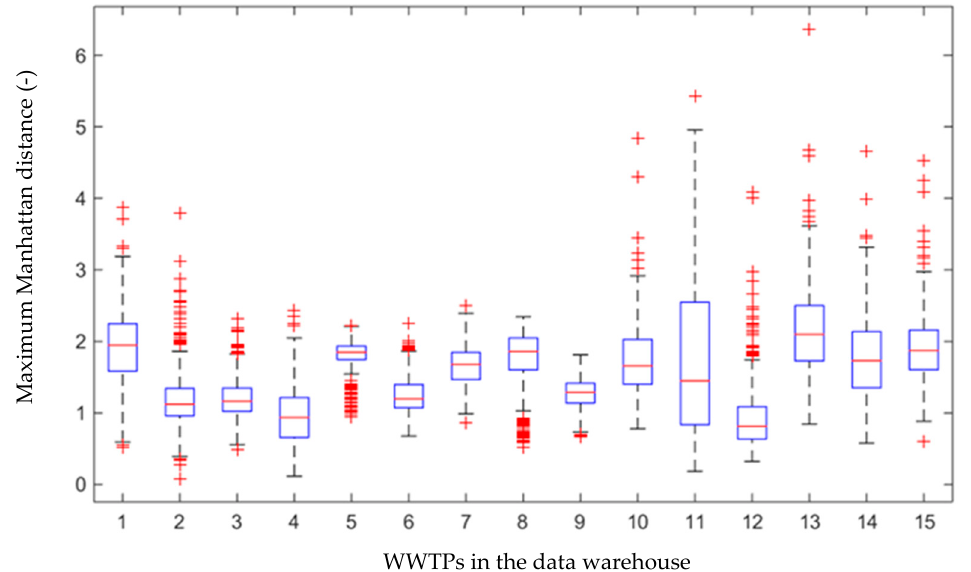
Figure 3. The maximum Manhattan distance of derived parameters in the data warehouse for part of the WWTPs.